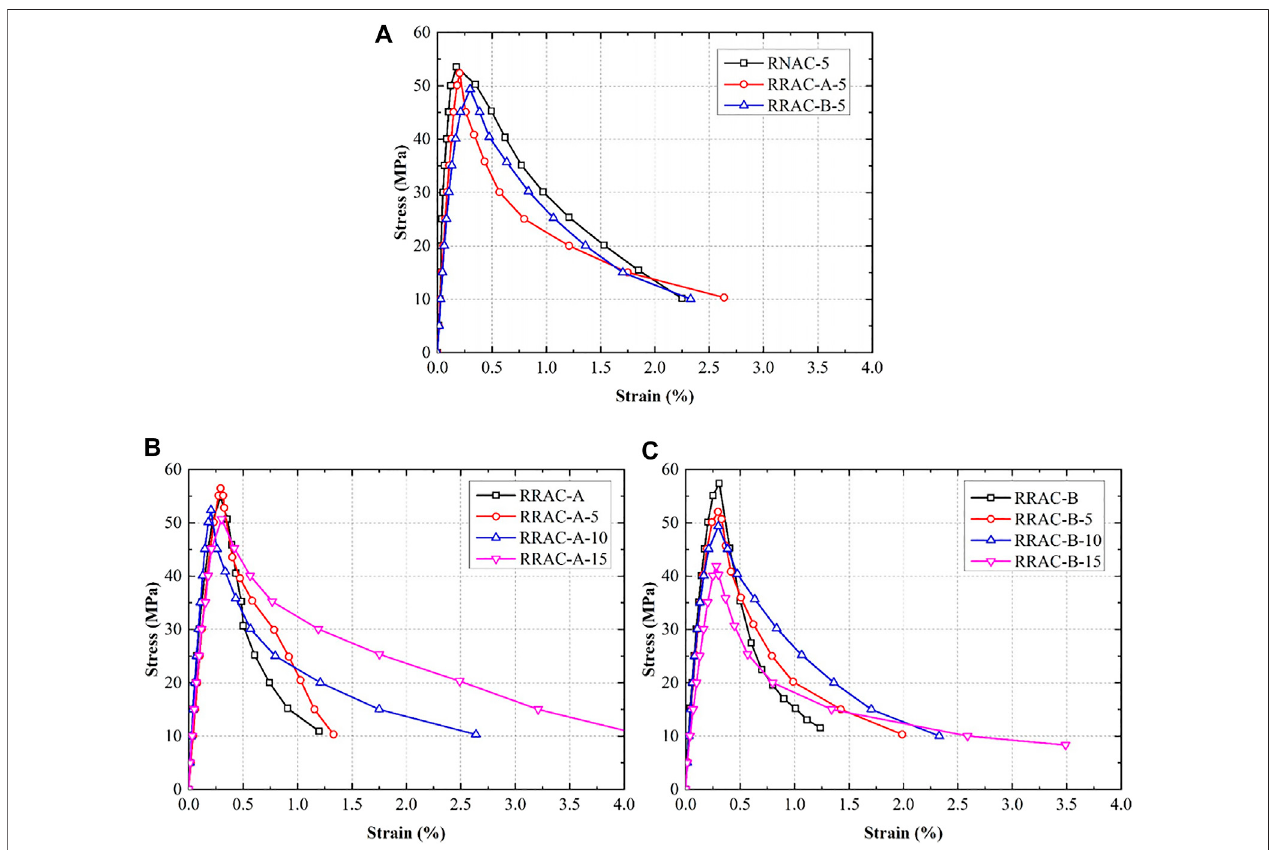
FIGURE 6 | Stress − strain curves of RRAC: (A) 5% rubber content; (B) RRAC-A; (C) RRAC-B.